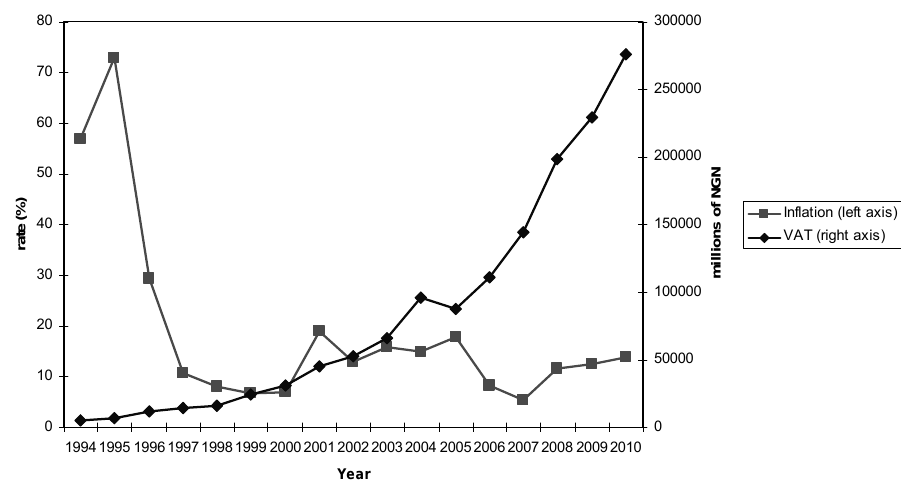
Figure 1. Evolution of inflation and VAT revenue,